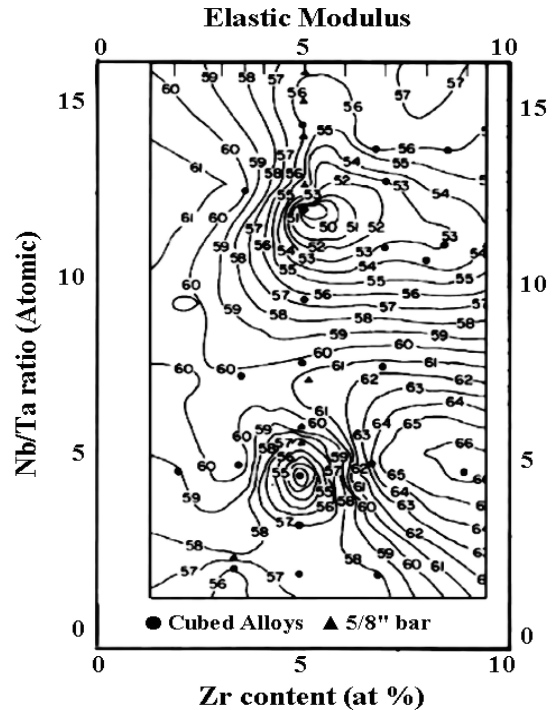
Figure 10. Modulus map for Ti-35Nb-7Zr-5Ta based on Nb/Ta ratio vs . Zr content [151]. Reprinted with permission from [151]. Copyright 2006 ASTM International.